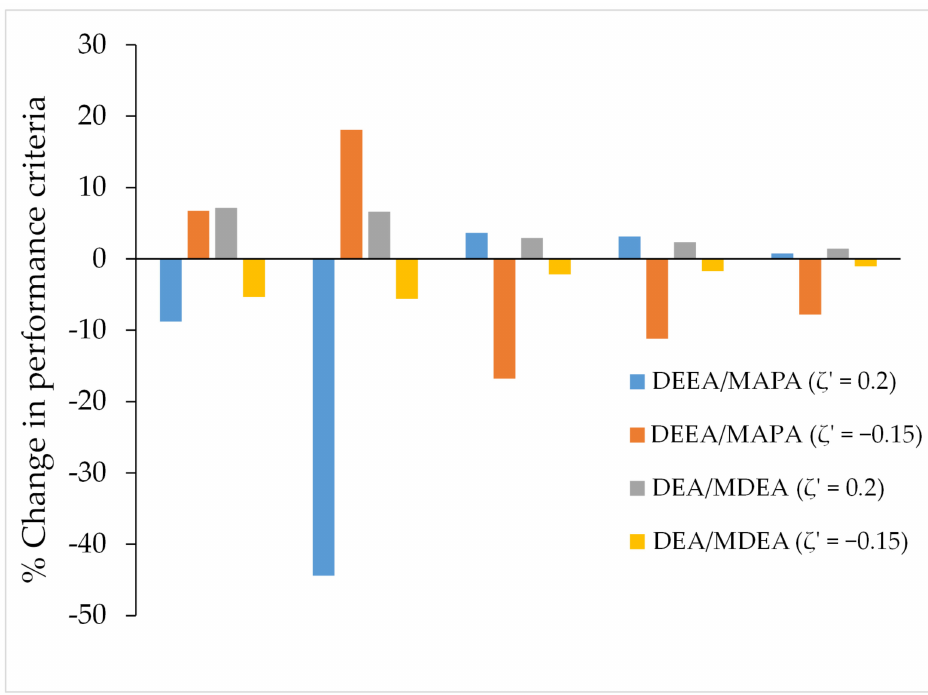
Figure 8. Change in the performance criteria for solvents DEEA / MAPA and DEA / MDEA for the investigated ζ (cid:48) = 0.2 and ζ (cid:48) = −